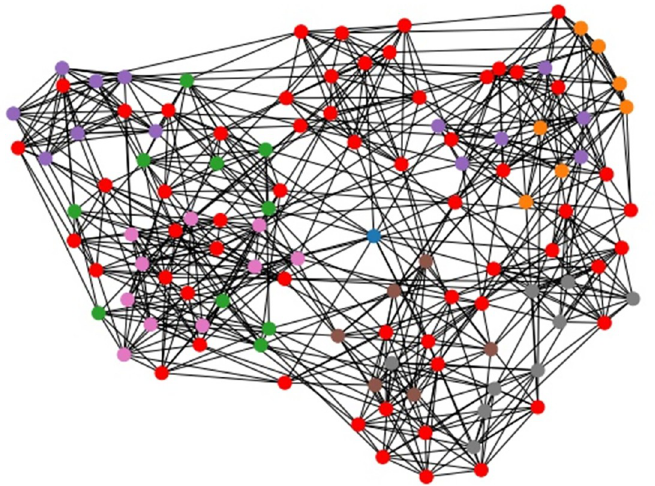
Fig 9. American college football community structure. Community structure obtained by LSE heuristic with W 0 weights and parameters n c = 7, p =